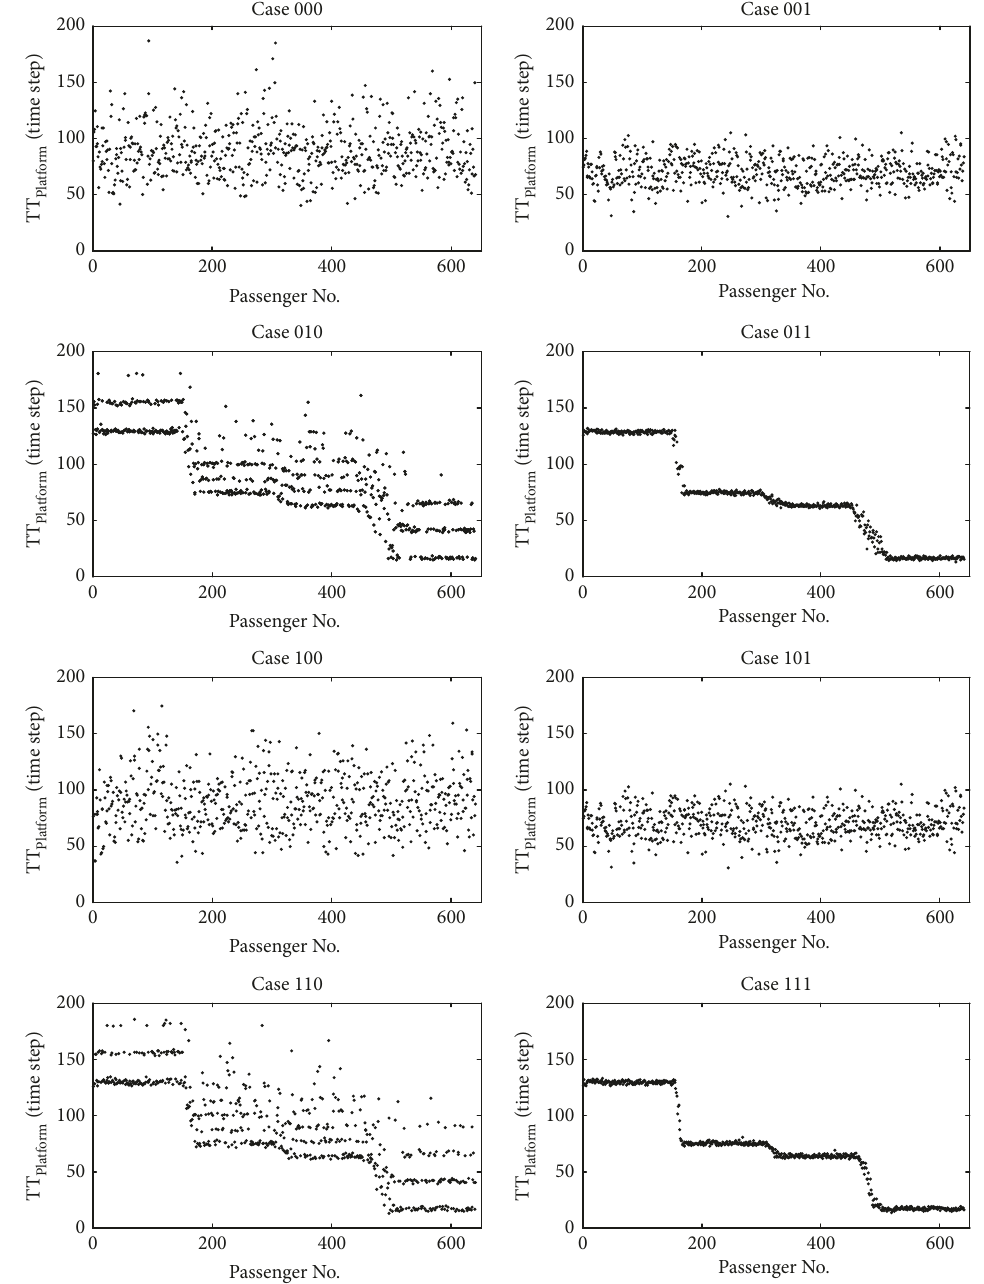
Figure 9: 𝑇𝑇 Platform under the eight